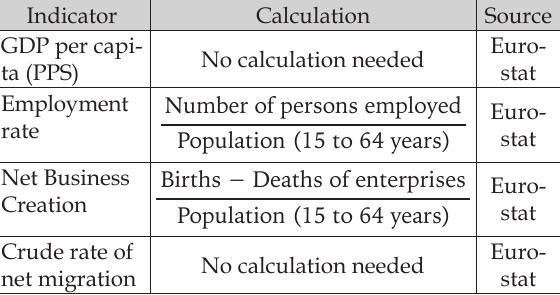
Table 2. Indicators used for the SSRR